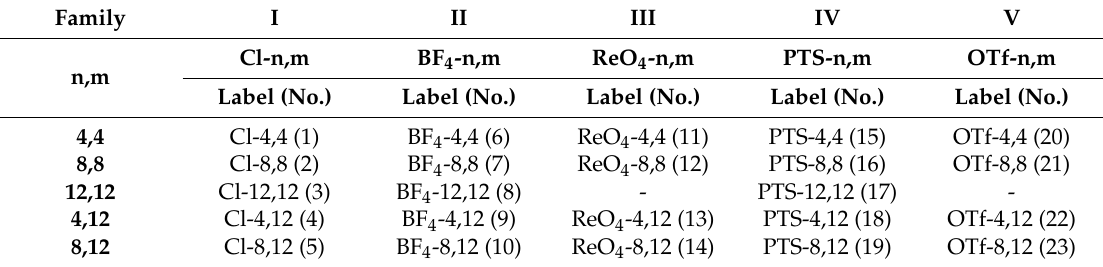
Figure 1. Pyrazolium salts described in this work [H 2 pz R(n)R(m) ][A]. Table 1. Numbering and nomenclature of the compounds [H 2 pz R(n)R(m)